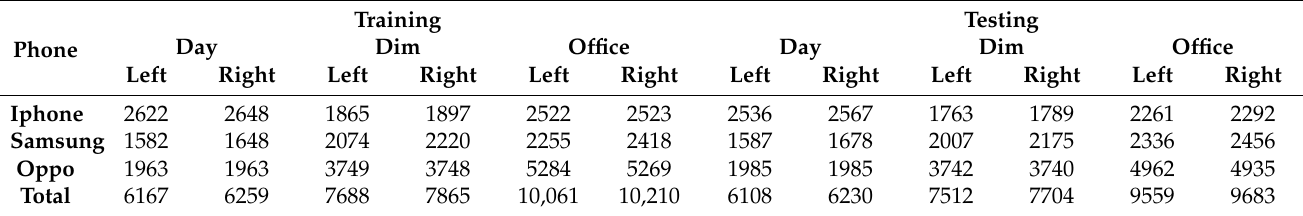
Table 3. Details of the training and testing sets of the VISOB dataset.